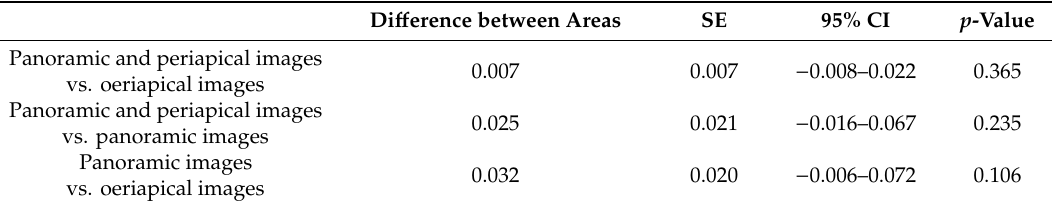
Table 2. Pairwise comparison of ROC curve for classification of six di ff erent types of DISs in the testing dataset.